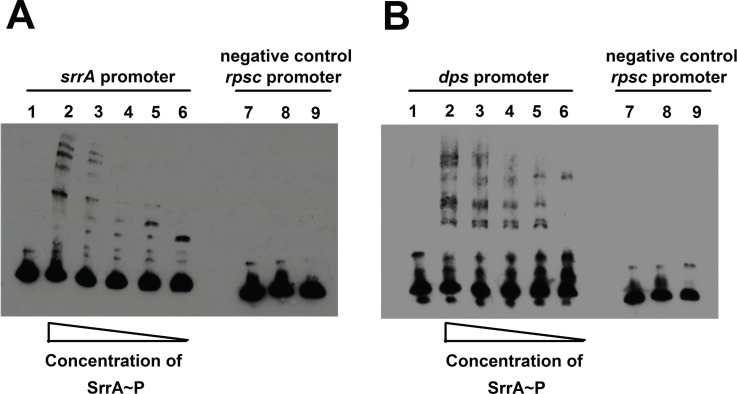
SrrA binds to DNA fragments immediately preceding the annotated transcriptional start sites for srrA and dps.Panels A and B; Electromobility gel shift assays (EMSAs) demonstrating binding of SrrA to DNAs that correspond to the 150 base pair segments immediately preceding the annotated transcriptional start sites for the srrA (A) and dps (B). EMSAs were performed with SrrA (15–146 ng) and 8 fM of biotin labeled DNA. For each gel, the samples in lane 1 contain 146 ng SrrA with labeled sample DNA and a 125-fold excess of non-labeled (cold) competitor DNA. The samples in lanes 2–5 contain labeled DNA with varying amounts of SrrA protein (15–146 ng). The samples in lane 6 contain labeled DNA, but no SrrA. The samples in lanes 7–9 show that the interaction of SrrA with DNA is specific. The samples in lane 7 contain 146 ng SrrA with rpsC promoter DNA and a 125-fold excess of non-labeled (cold) competitor DNA. The samples in lanes 8 contain rpsC promoter DNA with 146 ng of SrrA. The samples in lane 9 contain rpsC promoter DNA, but no SrrA.